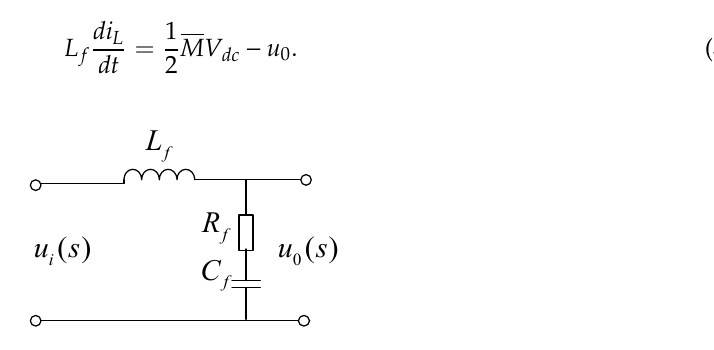
Figure 3. The structure of the LC filter.